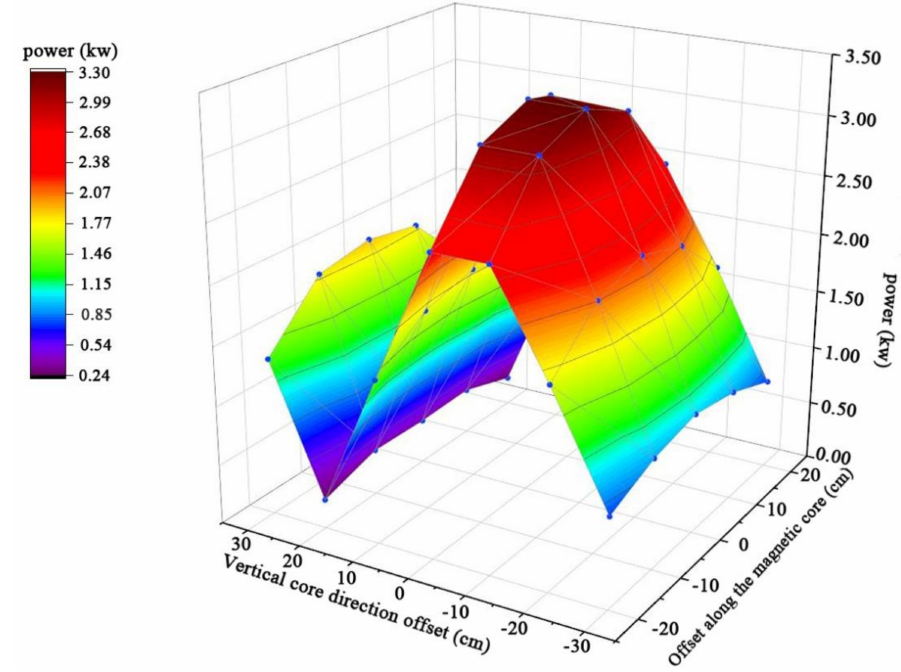
Figure 26. Variation diagram of system power with a horizontal